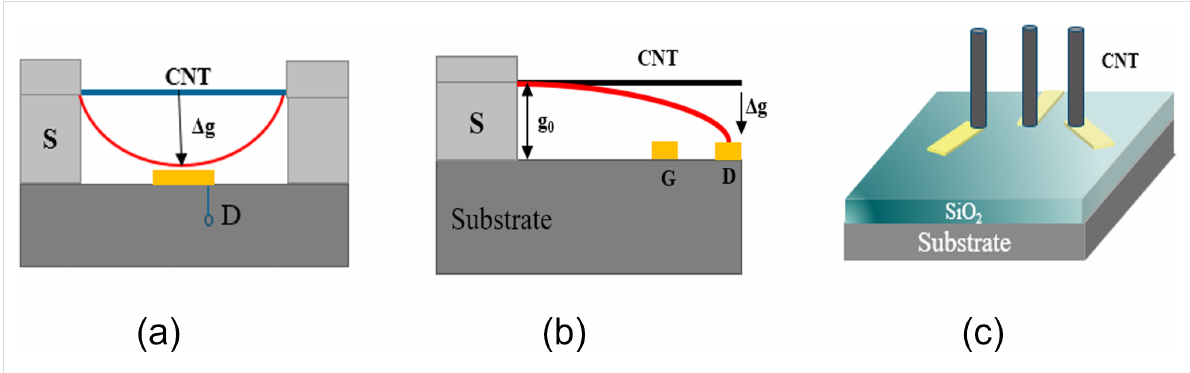
Figure 2: Structures of CNT switches. (a) Bridge model, (b) cantilever model, and (c) vertical model. Figure 2a,b,c were redrawn from [21], [22], and [18],